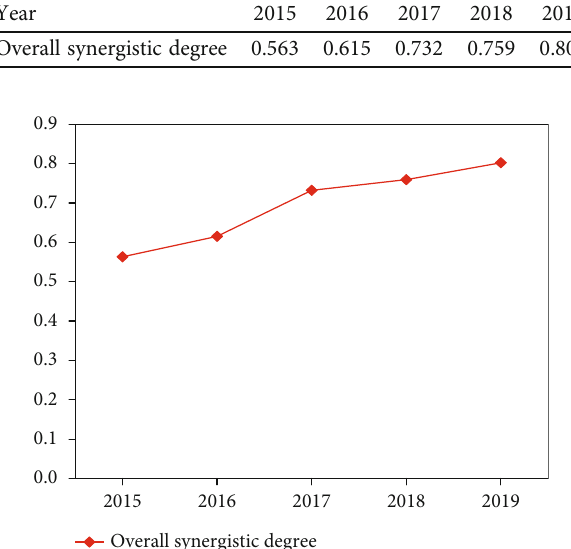
Figure 2: Overall synergistic degree of the CME management synergy system in Henan Province (2015-2019).